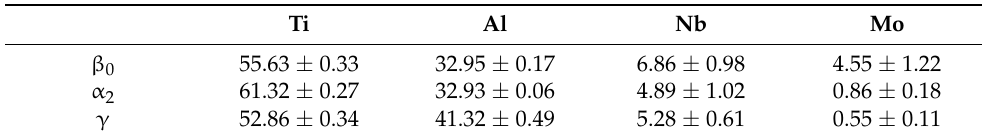
Figure 5. ( a ) STEM-HADDF image showing α 2 lamellae with β 0 particles precipitated in a P-HIPed TNM alloy after 1050 ◦ C/2 h/FC; ( b ) the SAED pattern; ( c ) HRTEM image of α 2 / β 0 / γ interface marked with the red circle in ( a ) and the corresponding FFT images. Table 2. TEM-EDX results showing the chemical composition of the β 0 , α 2 , and γ phases of TNM alloy after 1050 °C/2 h/FC (at.%).